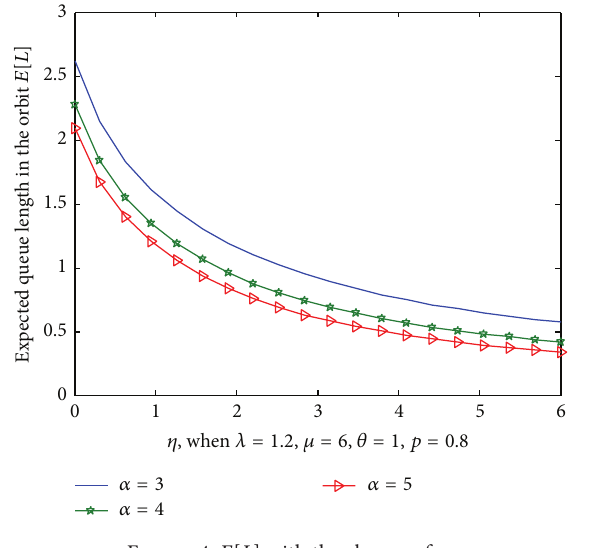
Figure 6: 𝐸[𝐿] with the change of 𝛼